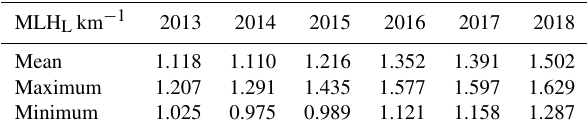
Figure 10. The correlation between MLH L and AOD, relative hu- midity, wind speed and temperature for measurements from 2014 to